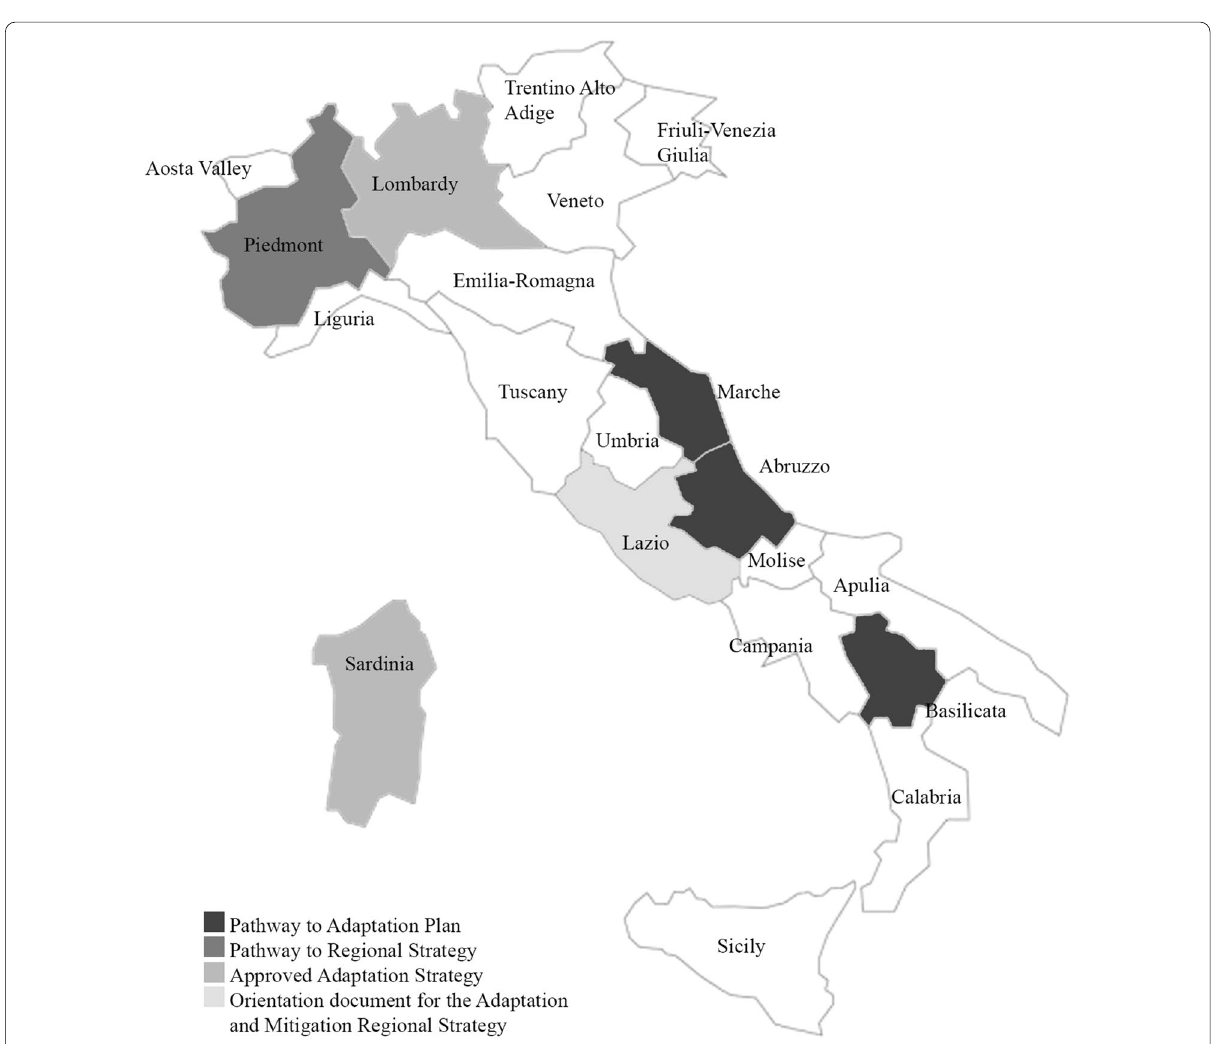
Fig. 1 Overview of regional resilience initiatives (updated 2020). Source: Authors’